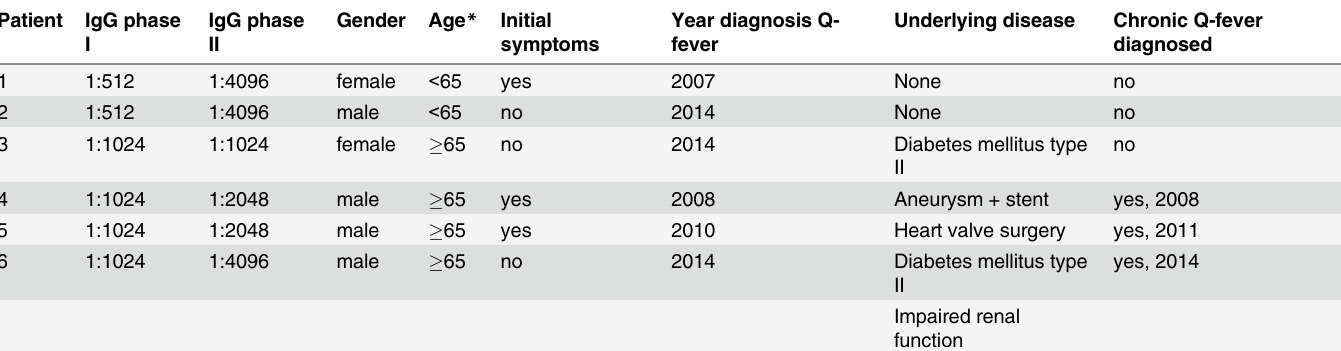
Table 2. Summary of the six participants with an IgG I titre (cid:1) 1:512 and Q-fever status after clinical examination. Patient IgG phase